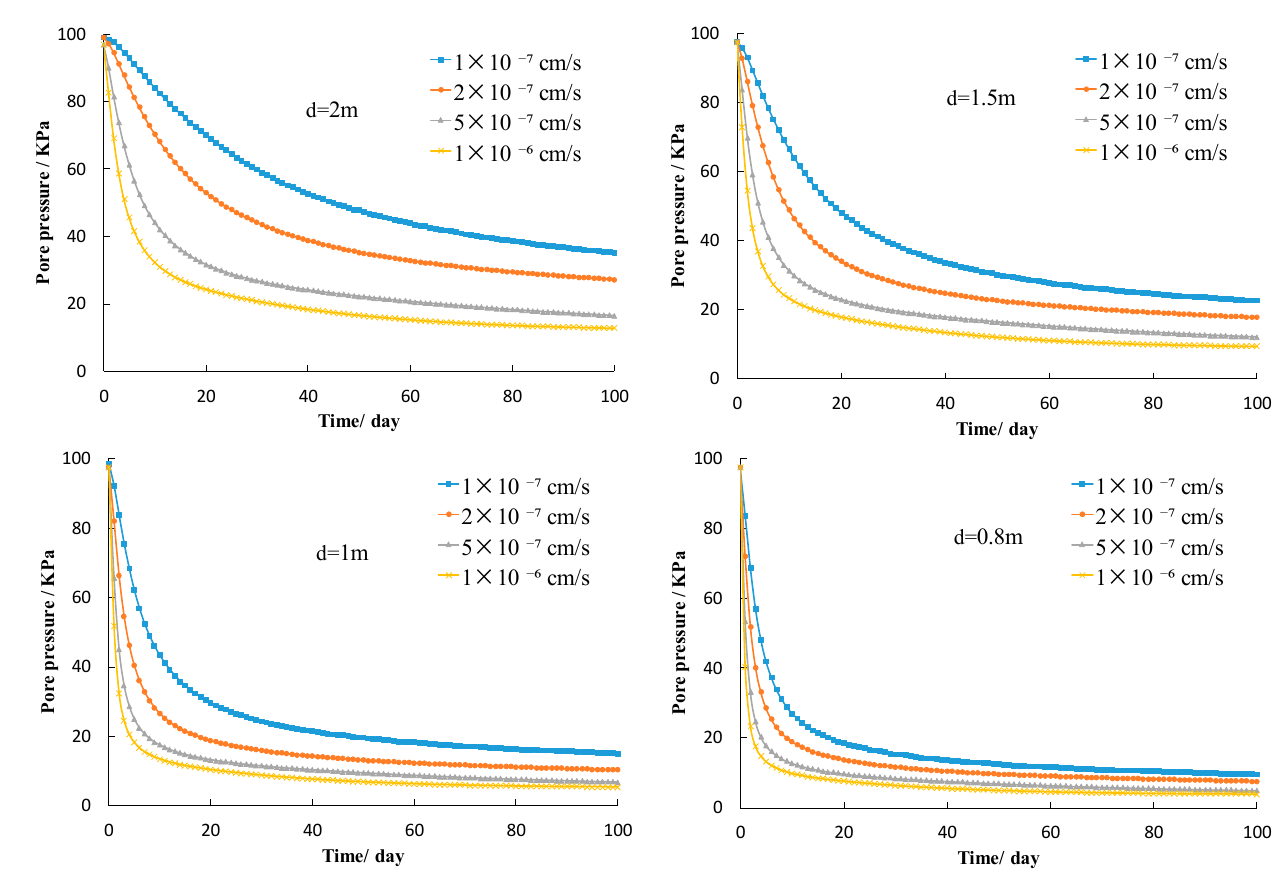
Figure 7. Pore water pressure at depth of 10 m at the corner of the square column changes over time. When the hole spacing is the same, the larger the permeability is, the faster the pore pressure drops rate is. When the soil permeability is the same, the smaller the drainage hole spacing is, the faster the pore pressure drop rate is. From the details, for the soils in which the permeability is 10 − 7 cm/s, it needs 74 days for 2 m hole-spacing condition to reduce the pore water pressure at the corner of the square column at 10 m depth into 40 kPa. As a comparison, it only needs 12 days for 1m hole-spacing condition to achieve the same pore water pressure. Thus, the spacing of siphon holes can be determined by the permeability of soft soils and the requirements of the construction period to achieve a balance between time and economy.